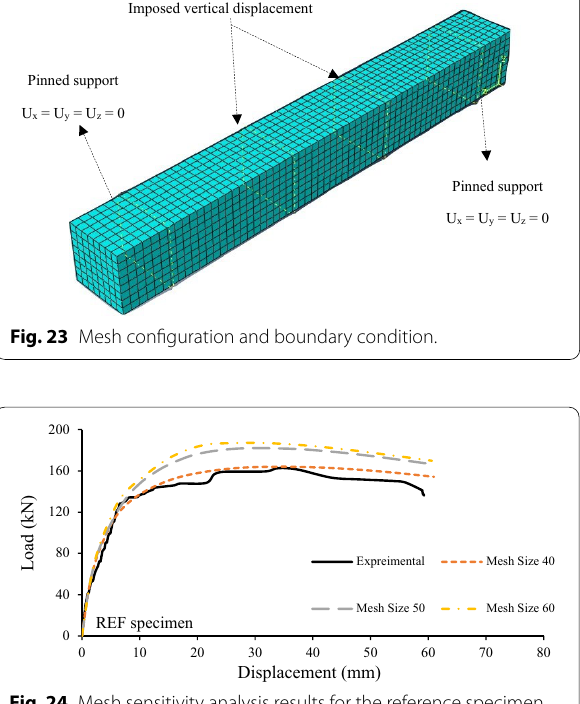
Table 2. The characteristics of the elastic performance of FRP sheets are reported in Table 12 (Ouni & Raza, 2021).